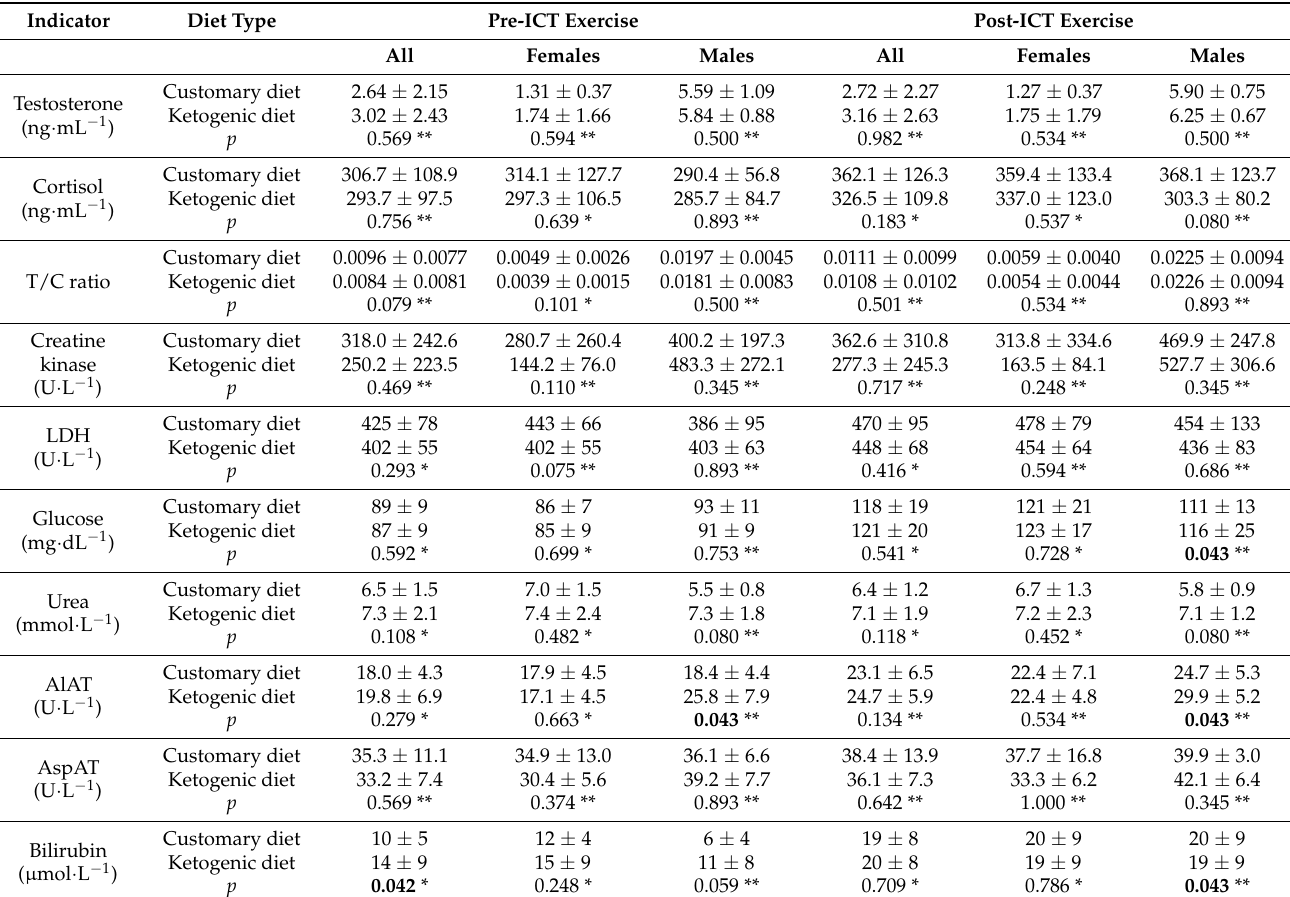
Table 4. Select hormonal, muscular, and metabolic function